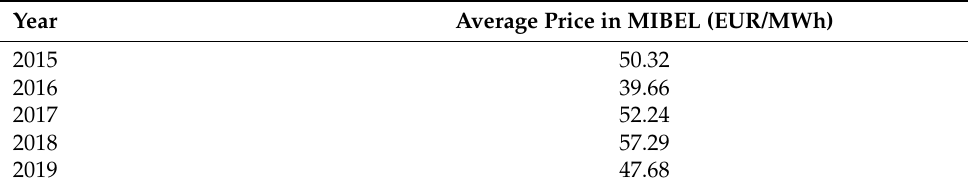
Table 11. Annual average MIBEL electricity prices in the 2015–2019